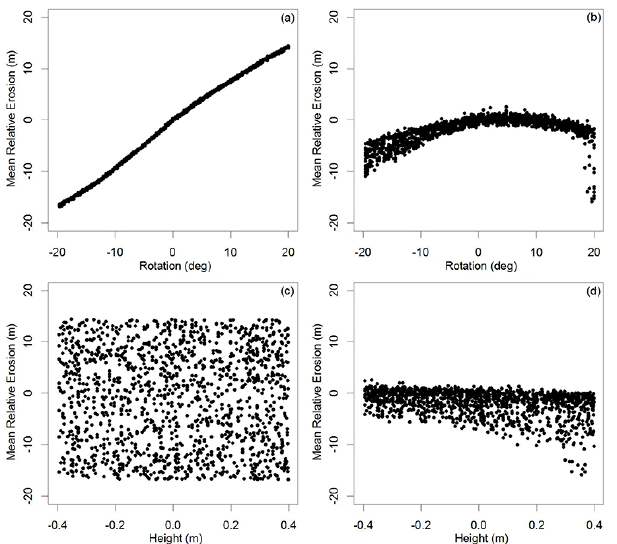
Figure 8. Wave height and rotation perturbation factors are plot- ted against each other for the north (a) and south (b) of the model domain. The size of each symbol is relative to the change in mean erosion rate imparted by that wave climate in comparison to the baseline scenario. Red dots represent increased erosion relative to the baseline and empty circles reduced erosion. Interpolated con- tour plots of the height change component of wave climate against the wave rotation component for the north (c) and south (d) of the model domain are also